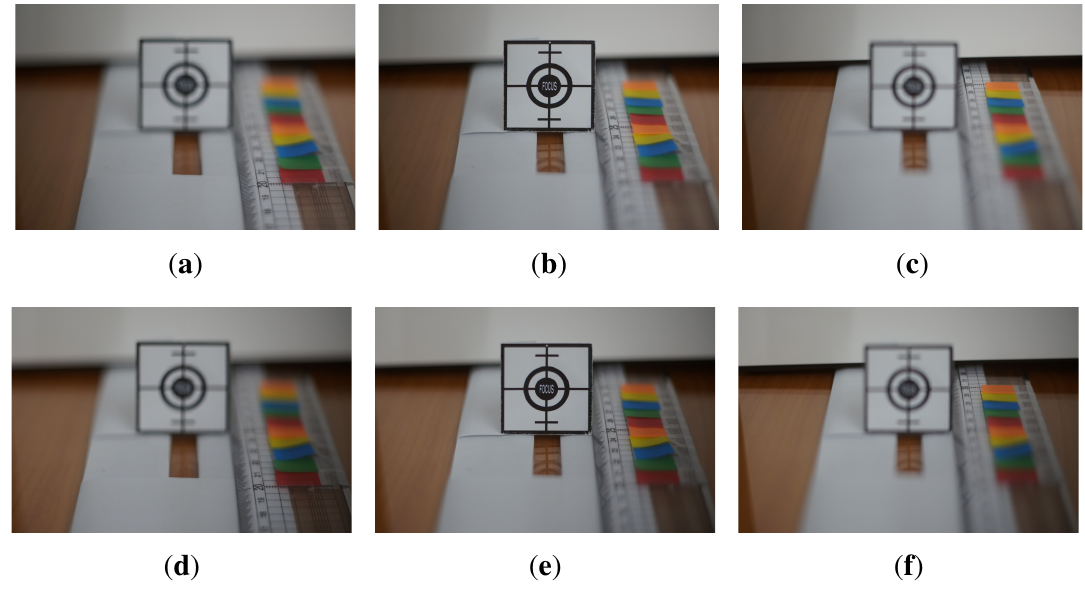
Figure 12. The set of differently-focused test images with 20 lux: ( a ) left-phase, front-focus image; ( b ) left-phase, in-focus image; ( c ) left-phase, far-focus image; ( d ) right-phase, front-focus image; ( e ) right-phase, in-focus image; and ( f ) right-phase, far-focus